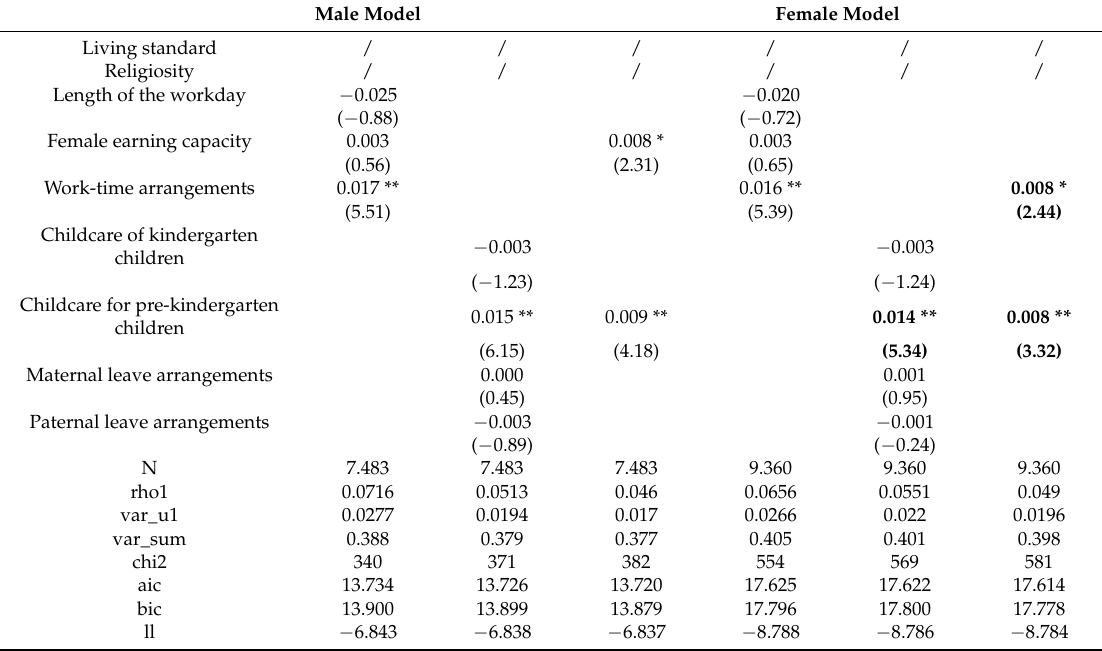
Table A6. Robustness check of macro-level variables (excluding macro-level controls—GDP and religiosity